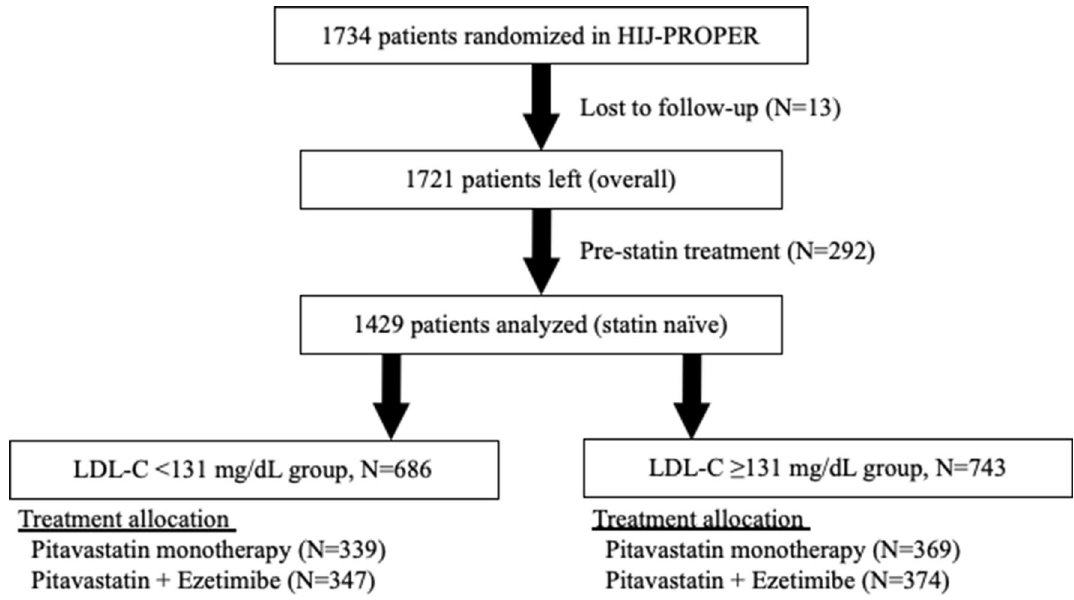
Figure 1. Study flow. LDL-C, low-density lipoprotein